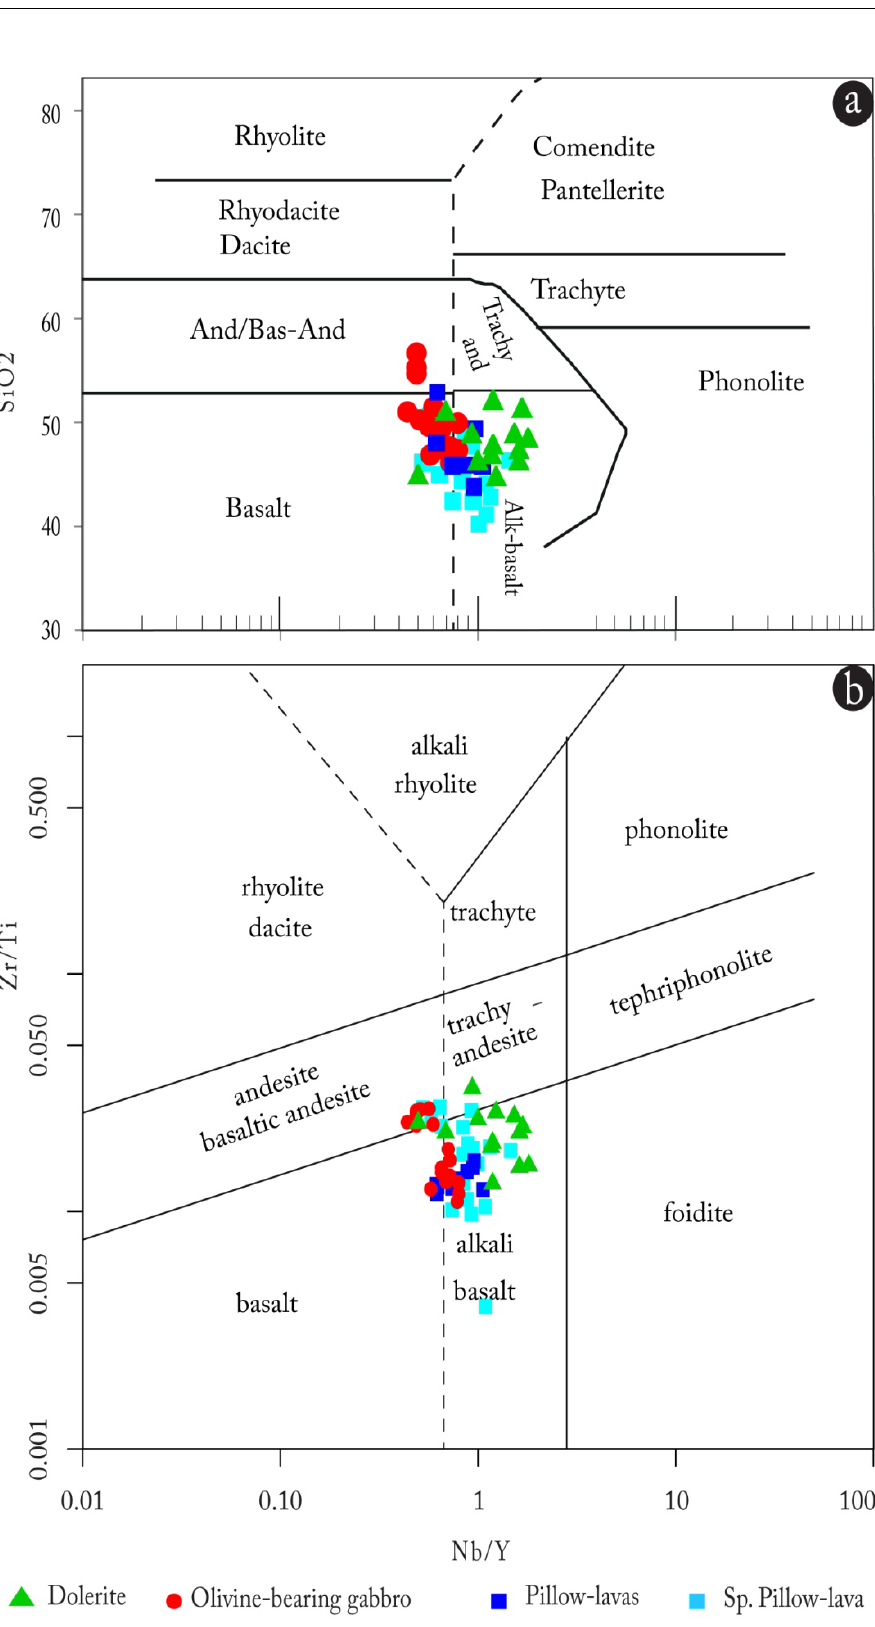
Figure 21. ( a ) Zr/TiO2 vs. Nb/Y and [60] ( b ) SiO2 vs. Nb/Y [59] diagrams. Dotted lines: boundary between the sub-alkaline (on the left) and alkali (on the right) fields.